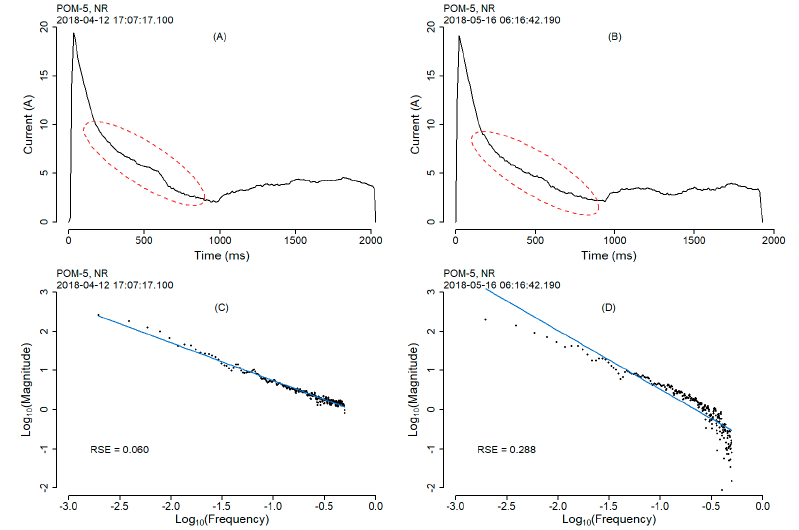
Figure 7. Actuation events of point-operating machine POM-5 in the NR direction. The events are recorded on two separate days—2018-04-12 ( A ) and 2018-05-16 ( B )—with their FFT log 10 transformation and linear curve from each event directly below ( C and D ). The red ellipse ( A and B ) highlights the area of the two actuation events that show variability in the signal, which is reflected in the observed RSE values.